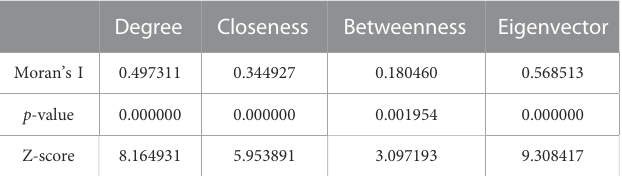
TABLE 3 Node centralities of cities and the result of global spatial autocorrelation.